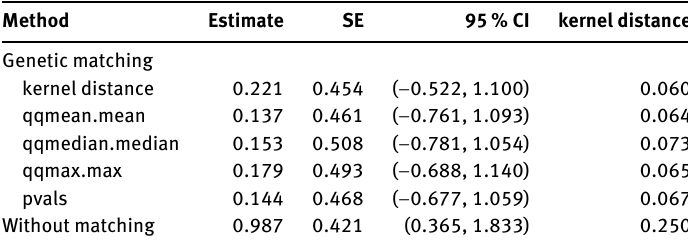
Table 7: Causal Log Odds Ratio Estimates for Different